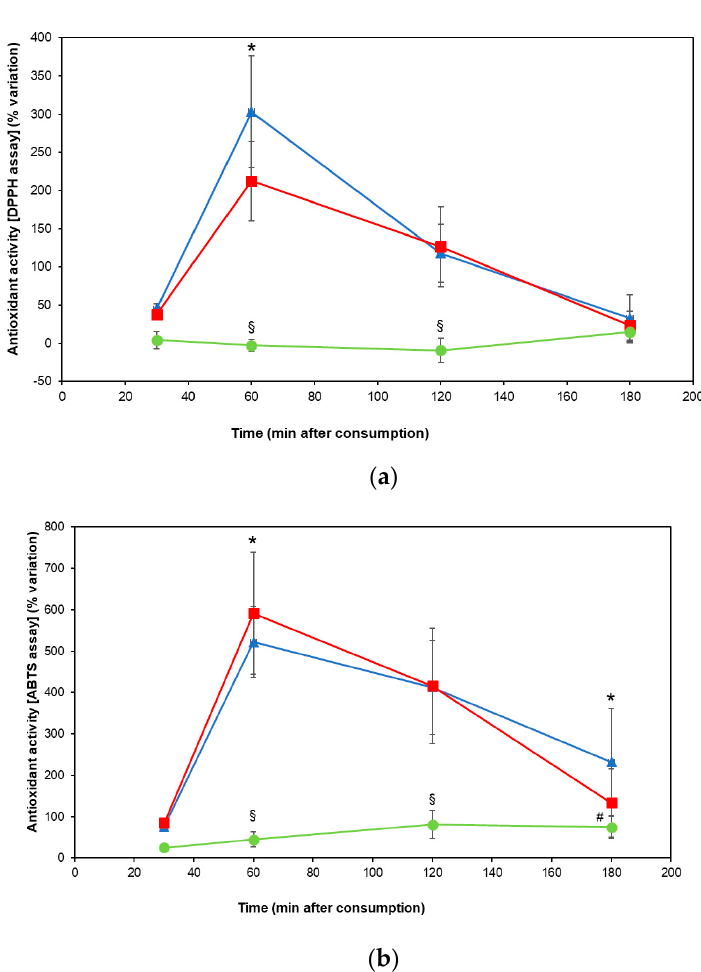
Figure 3. ( a ) Percentage variation (mean ± standard error) in the plasma antiradical capacity (DPPH radical scavenging assay) of volunteers (N = 19) 30, 60, 120 and 180 min after consuming 100 g of Venere (square), Artemide (triangle) or Carnaroli (circle) rice. The symbol (§) indicates statistically significant di ff erences between Carnaroli rice and the pigmented varieties ( p < 0.01); the symbol (*) indicates statistically significant di ff erences between Venere and Artemide rice ( p < 0.05). ( b ) Percentage variation (mean ± standard error) of the plasma antiradical capacity (ABTS radical scavenging assay) of volunteers (N = 19) 30, 60, 120 and 180 min after consuming 100 g of Venere (square), Artemide (triangle) or Carnaroli (circle) rice. The symbol (§) indicates statistically significant di ff erences between Carnaroli rice and the pigmented varieties ( p < 0.01); the symbol (#) indicates statistically significant di ff erences between Carnaroli and Artemide rice ( p < 0.05); the symbol (*) indicates statistically significant di ff erences between Venere and Artemide rice ( p <